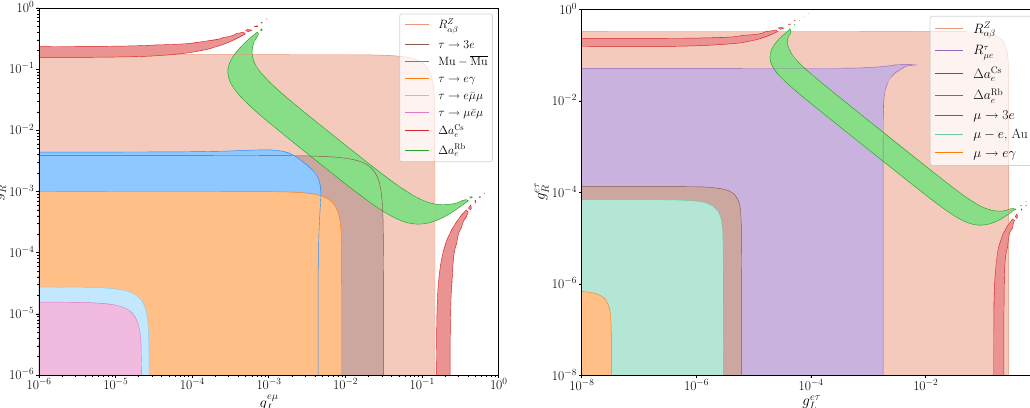
μ Fig. 7 Constraints on the g e (left) and g e τ (right) couplings and L , R L , R μτ prospects for ( g − 2 ) e for fixed values of g . On the left, allowed L , R μ μ regions in the ( g e - g e ) parameter space, in agreement with constraints L R from cLFV τ decays ( τ → 3 e in brown, τ → e γ in orange, τ → e ¯ μμ in light blue and τ → μ ¯ e μ in pink) and Muonium oscillations (blue);